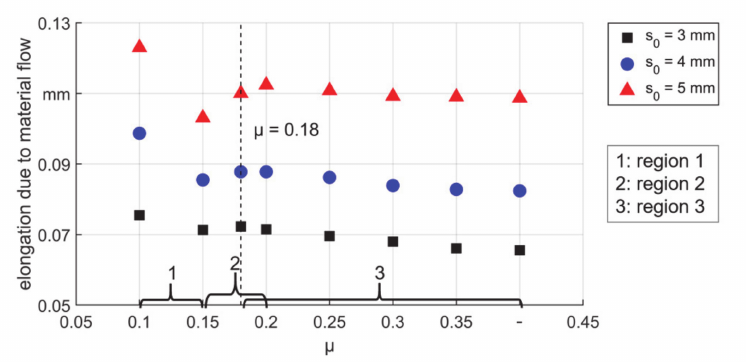
Figure 11. Elongation between A and B after one stroke due to material